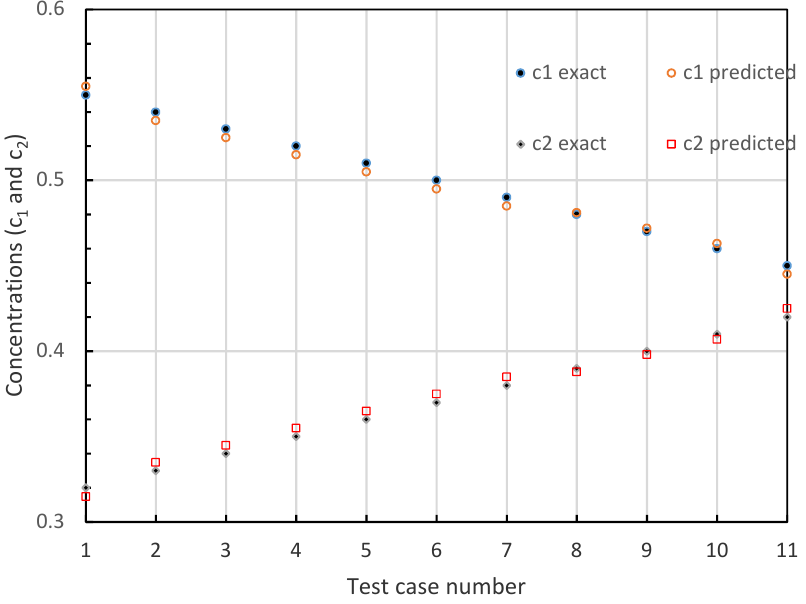
Figure 6. The ELM predicted concentrations vs. exact target values. Table 1. ELM predicted results and exact values.